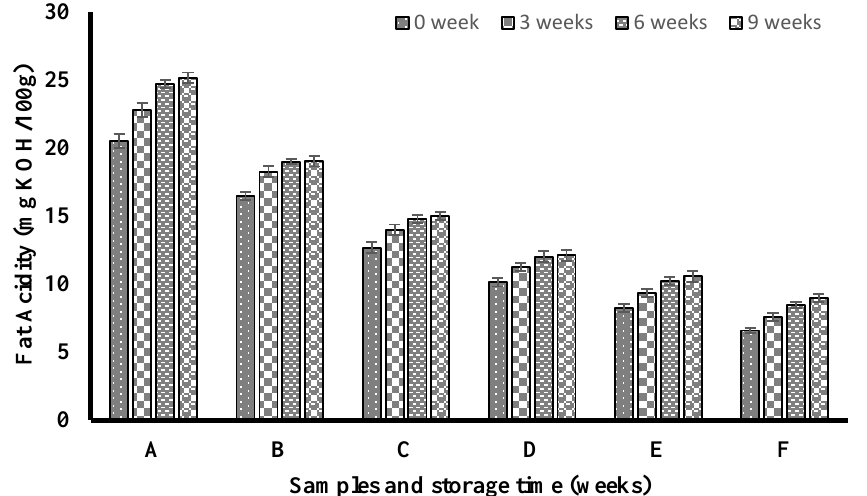
Figure 2. Fat acidity of control and composite flour made from mature, unripe pawpaw fruit flour and wheat flour stored for nine weeks. Keys: A is 100% wheat flour; B is 90% wheat and 10% mature, unripe pawpaw fruit flour; C is 80% wheat and 20% mature, unripe pawpaw fruit flour; D is 70% wheat and 30% mature, unripe pawpaw fruit flour; E is 60% wheat and 40% mature, unripe pawpaw fruit flour; F is 50% wheat and 50% mature, unripe pawpaw fruit flour.